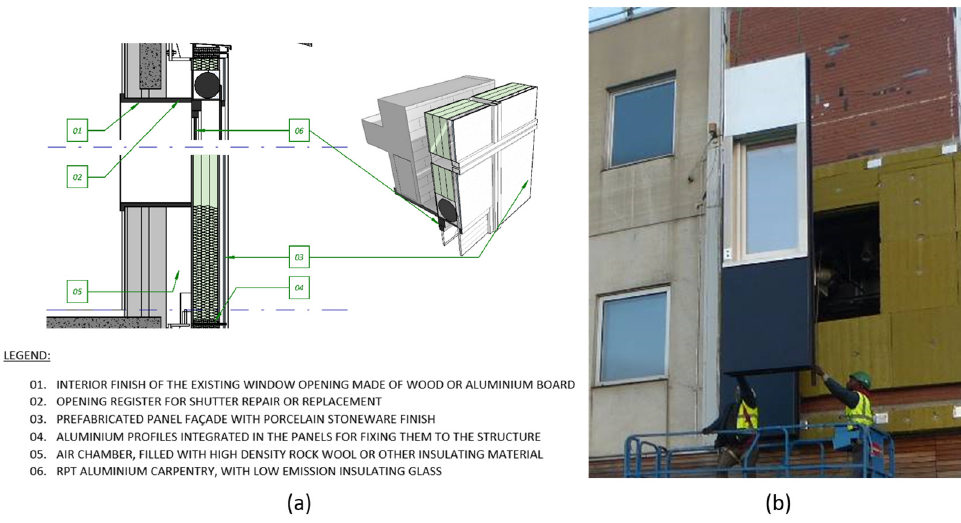
Figure 8. ( a ) Cross section and parts of the fenestration unit; ( b ) real image of fenestration